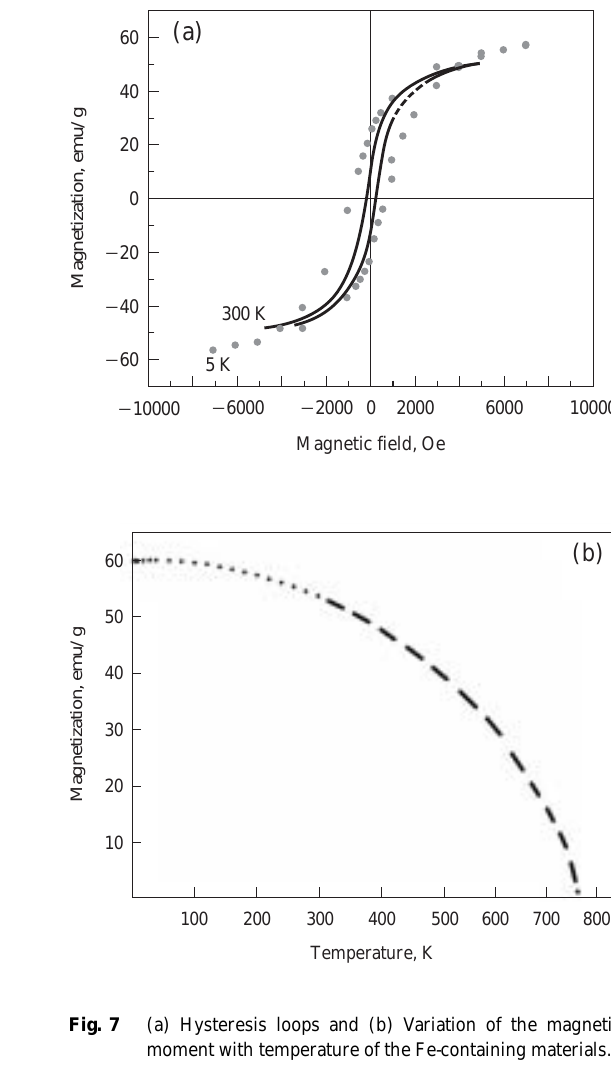
Fig. 7 (a) Hysteresis loops and (b) Variation of the magnetic moment with temperature of the Fe-containing materials.